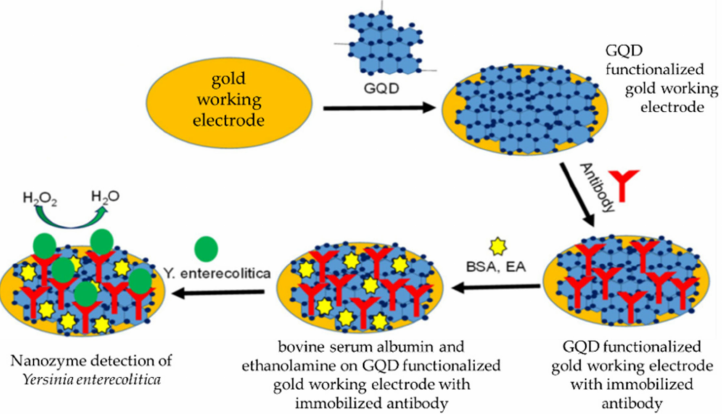
Figure 5. Preparation of the GQD working electrode of the immunosensor (reproduced with minor modification from Savas et al., (2019) [77] under the creative commons attribution license